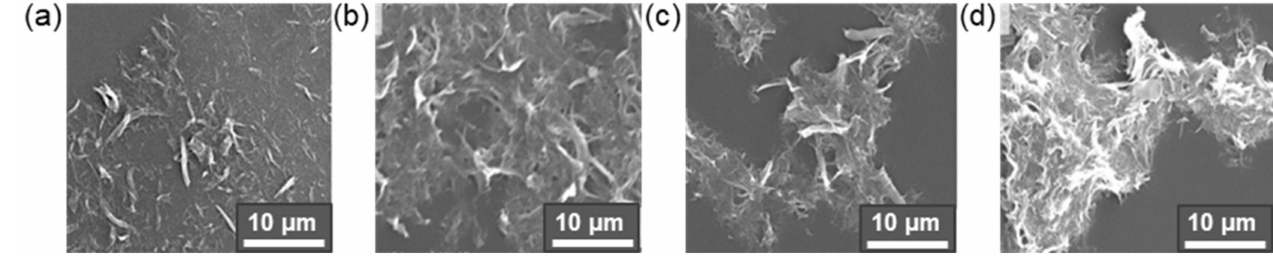
Figure 7. SEM images of CNF before ( a ) and after modification with acetic ( b ), propionic ( c ), and butyric ( d ) anhydrides (reaction time was 4 h). Reproduced from Supplementary Materials of [152], published under the terms of the Creative Commons CC BY